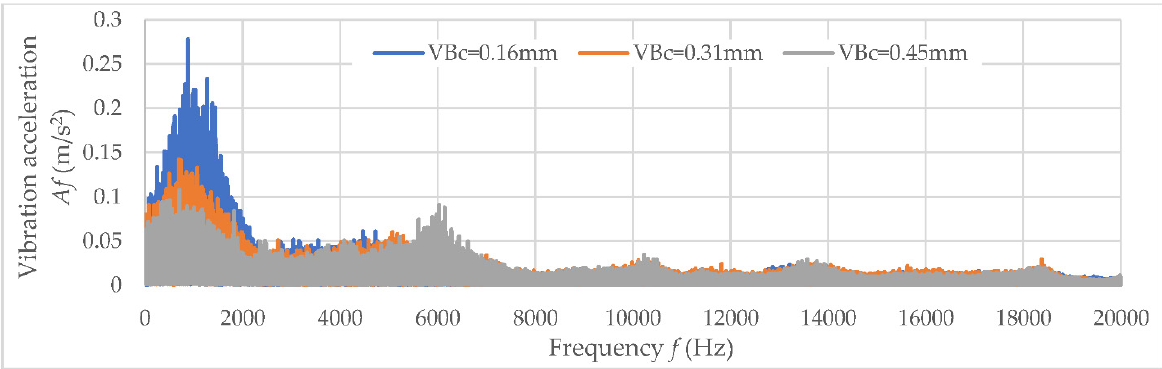
Figure 11. The amplitude-frequency characteristics for main analyzed direction Af.